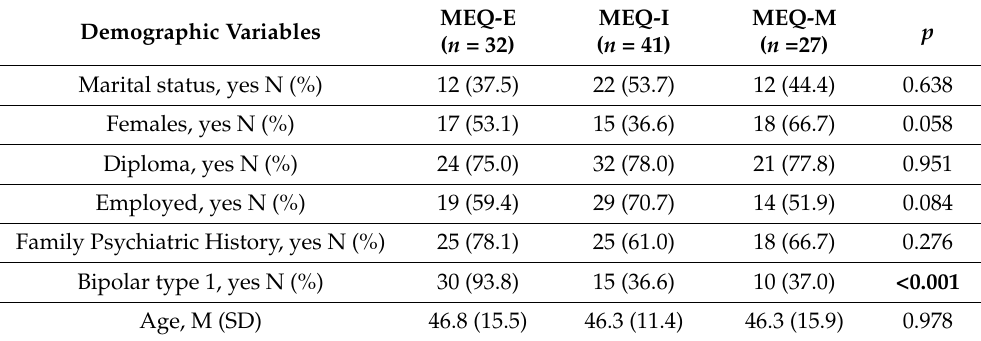
Table 1. Socio-demographic and clinical variables across different chronotypes: descriptive analyses.